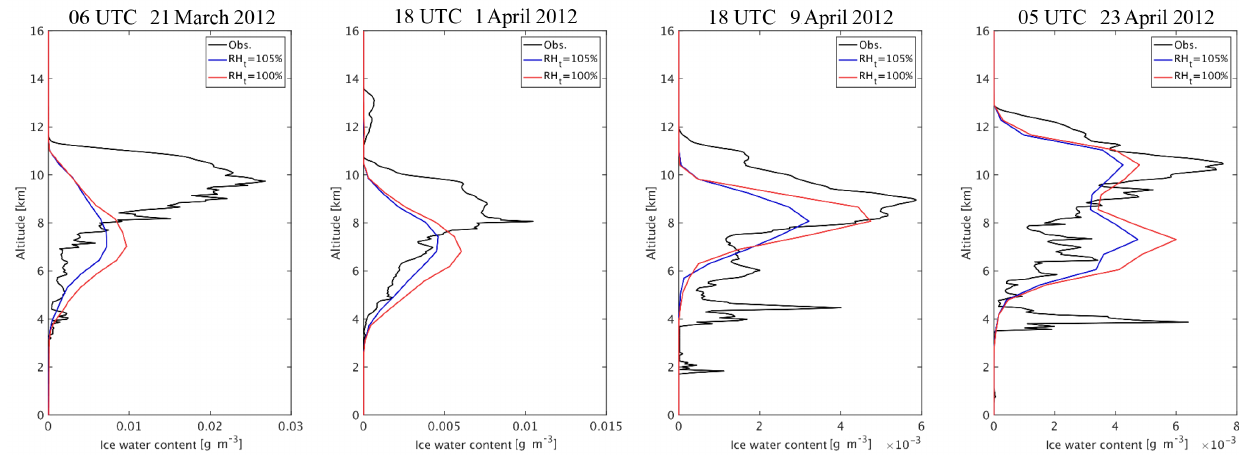
Figure 12. Vertical profiles for the mean observational IWC from CALIPSO and the simulated IWC with threshold RH values of 105 and 100% for the dust events on 21 March and 1, 9, and 23 April